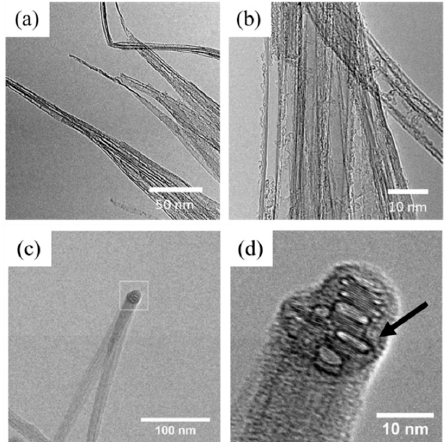
Figure 4. TEM investigation of the nanostructure of Dicyclopentadiene (DCPD)-infused CNT bundles. ( a ) A representative TEM image of DCPD-infused CNT bundles. ( b ) High magnification of a few bundles infused with DCPD. ( c ) A kinked DCPD–CNT bundle. ( d ) Enhanced magnification of the kink highlighted in the box in ( c ). The arrow indicates the DCPD sheath outside of the CNT